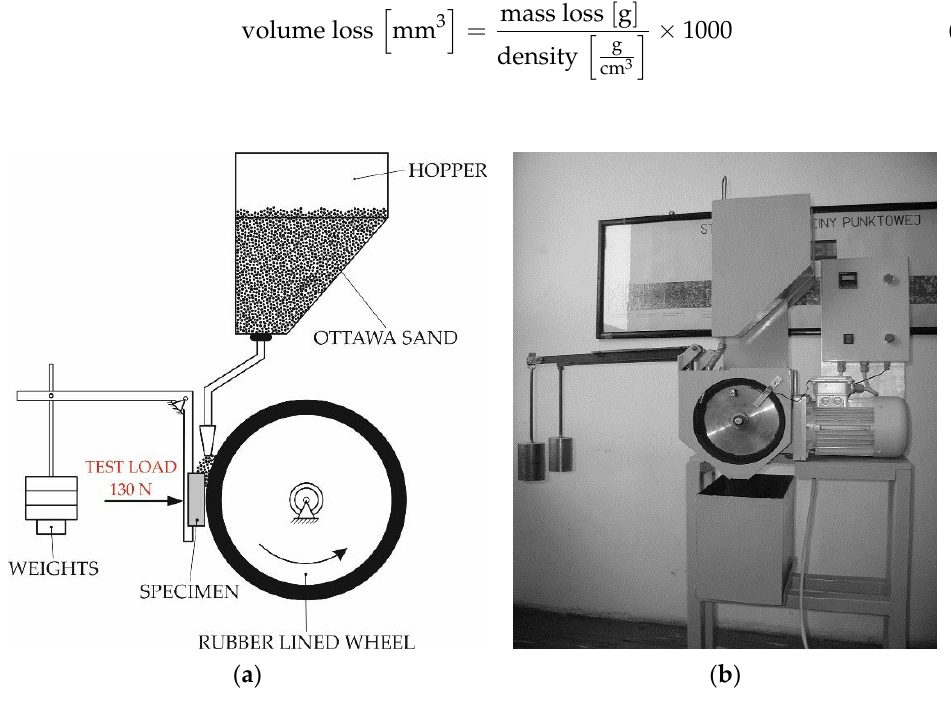
Figure 7. Testing station for metal-mineral abrasive wear resistance tests in performed in accordance with ASTM G65: ( a ) schematic diagram and ( b ) main view [30].